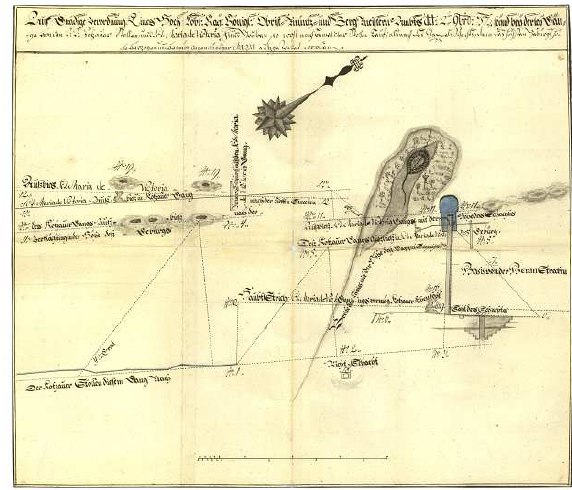
Figure 1. Mines in Jáchymov (1757) – from Č GS archive